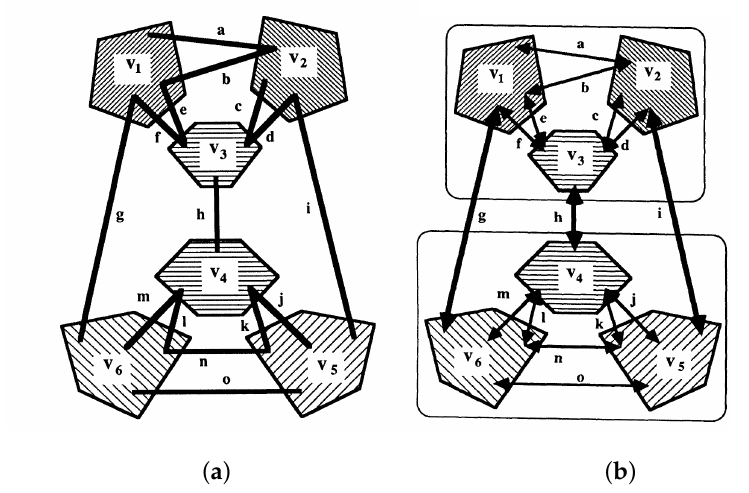
Figure 47. A plane body-bar framework ( a ), with a decomposition into generically rigid components with further connections ( b )